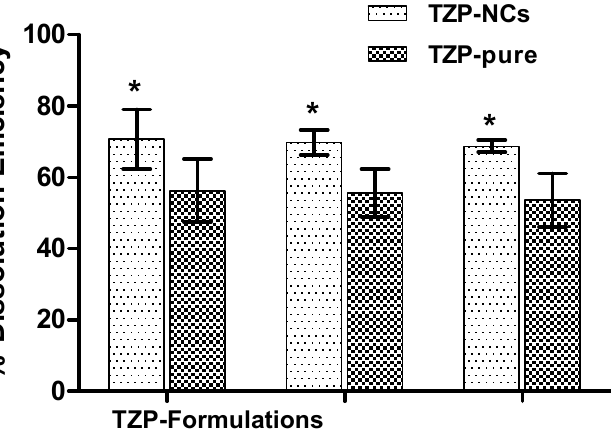
Figure 9. Dissolution efficiencies (%DE) with 95% confidence intervals of TZP-NCs versus TZP − AqS, where * p < 0.0005 was indicating the significant difference between the %DE of the two formulations.